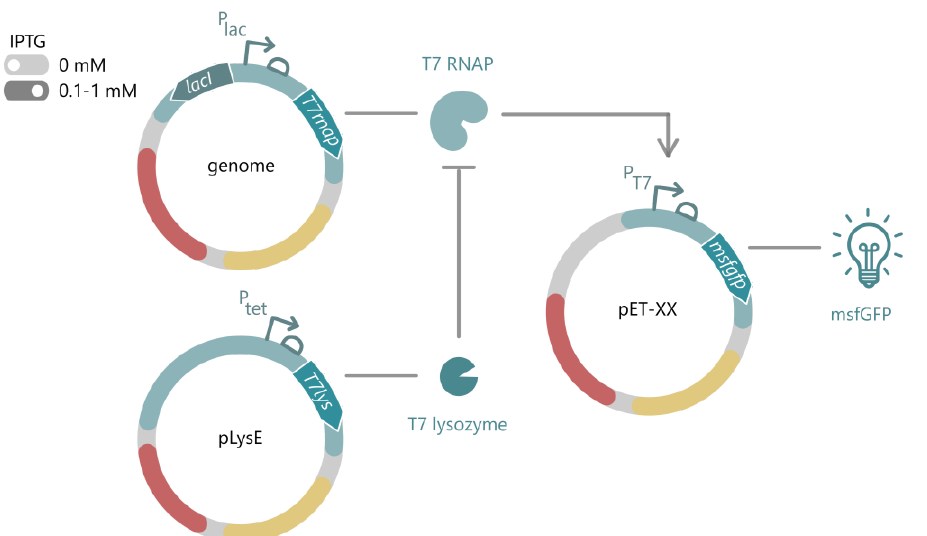
Figure 1. General layout of the T7-based pET system for E. coli . The T7 RNAP is stably integrated into the host genome with an IPTG-inducible expression cassette. In the absence of IPTG (light grey), the system is considered off, while upon addition of IPTG (dark grey, usually 0.1–1 mM IPTG), the T7 RNAP is expressed from the LacI/ Plac system. The T7 RNAP drives expression of a gene of interest, here depicted as an msfGFP , from its putative T7 promoter on any pET vector. To express toxic proteins, alternative hosts are available, carrying the pLys vector for expression of the T7 lysozyme, which inhibits transcriptional activity of the T7 RNAP in uninduced conditions. IPTG: isopropyl-β-D-thiogalactopyranoside, T7 RNAP: T7 RNA polymerase, msfGFP: monomeric superfolder green fluorescent protein.